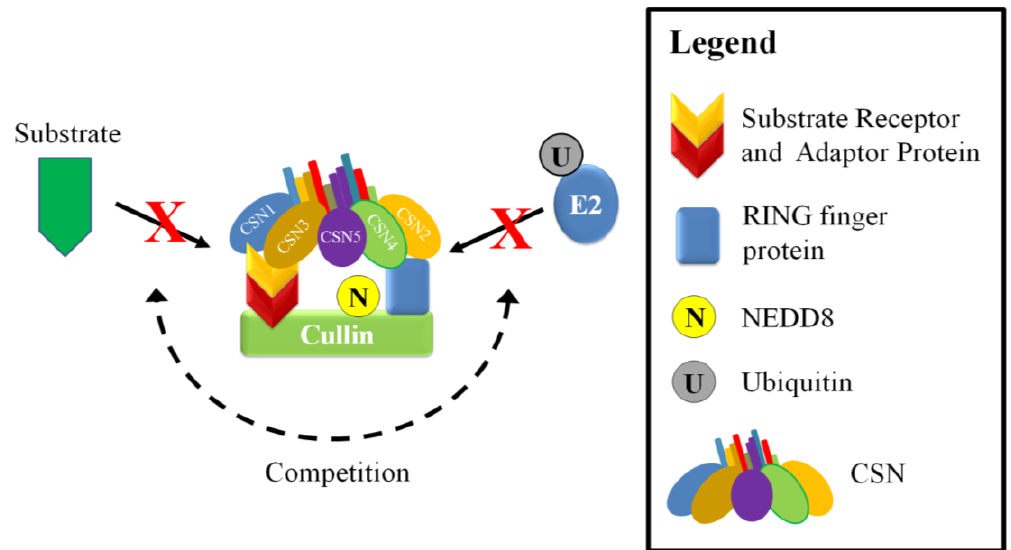
Figure 4. A schematic model of neddylation-independent regulation of CRLs by the CSN. The CSN interaction can inhibit CRLs in a neddylation independent manner by competing with substrates and ubiquitin-E2s for binding sites.